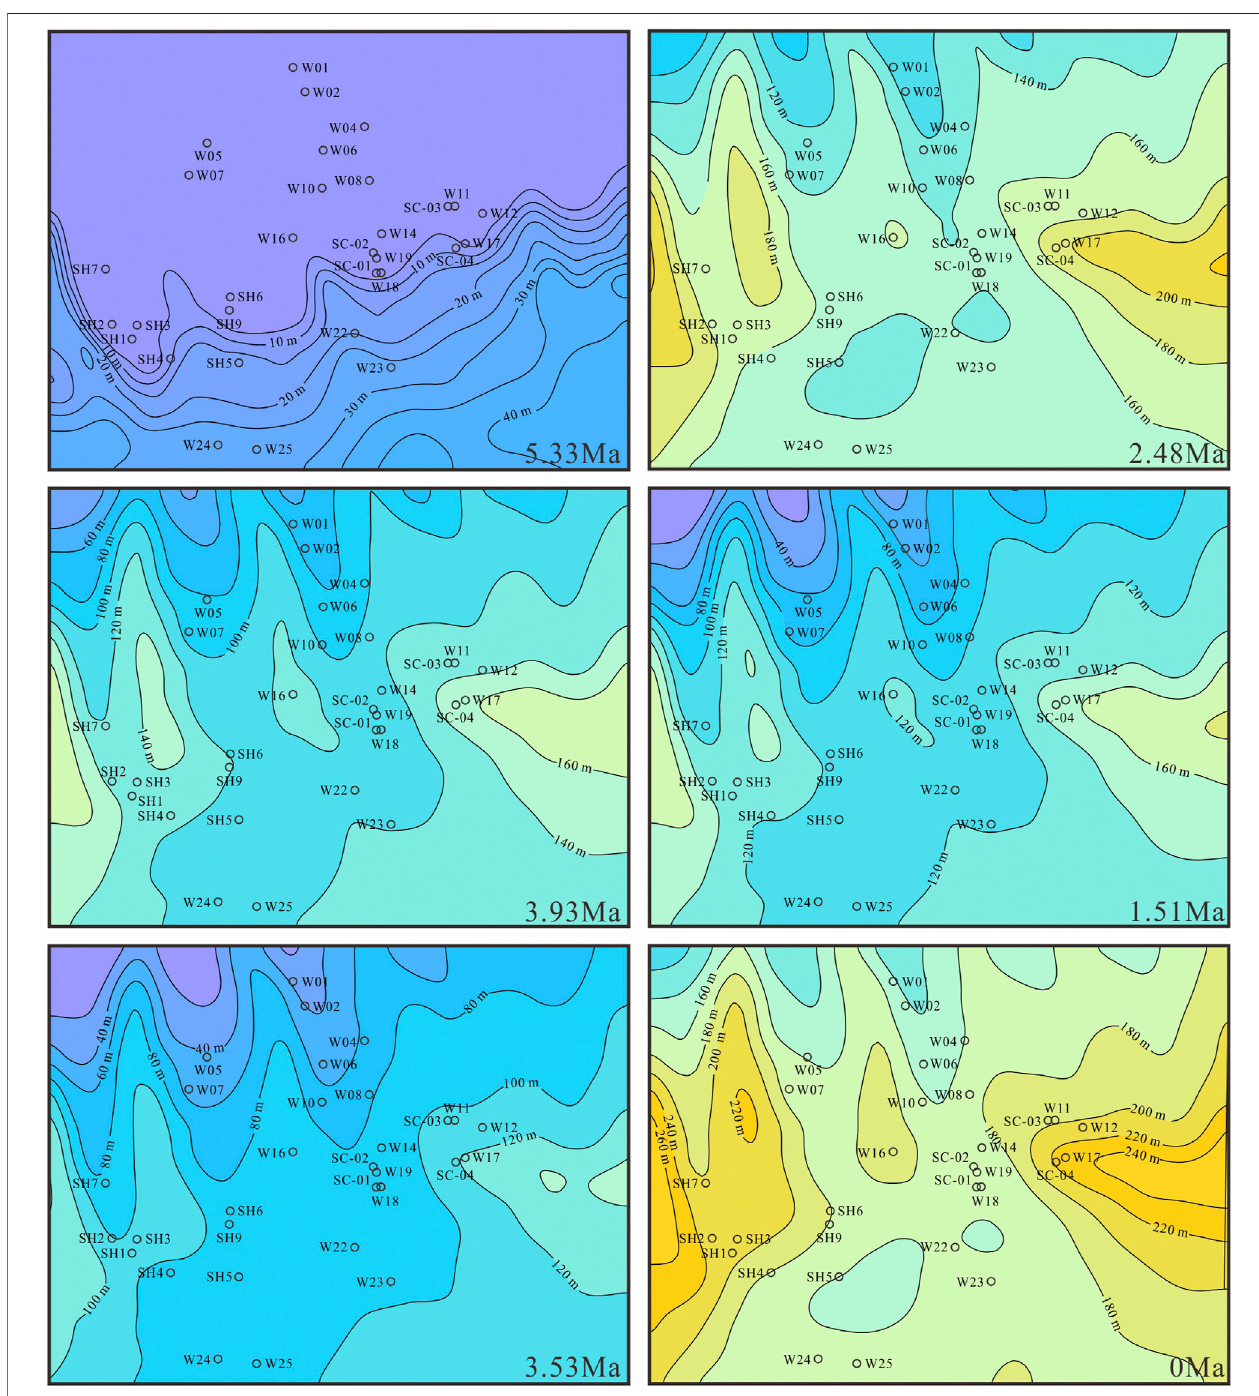
FIGURE 5 | Thickness variation in the GHSZ in the Shenhu area since 5.33 Ma.